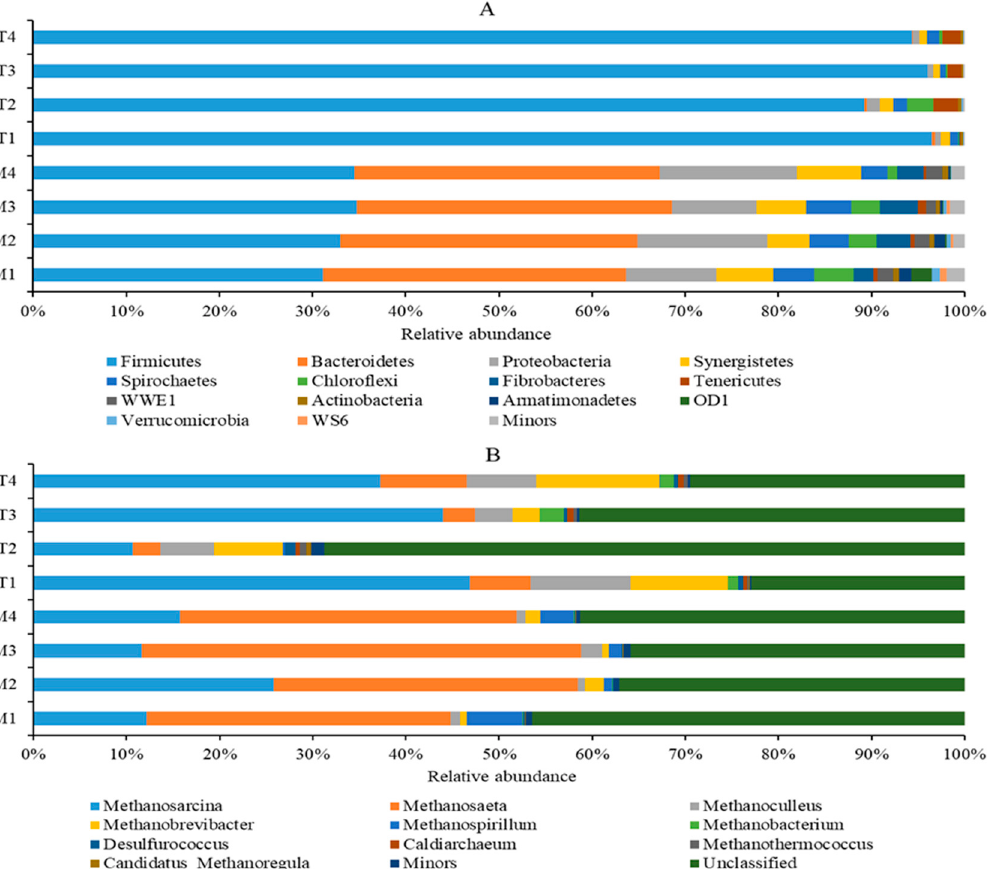
Figure 4. Microbial profiles of the bacterial genera ( A ) and the archaeal genera ( B ) (only bacterial and archaeal genera with relative abundance of ≥ 0.5% in at least one digester are presented; the rest were classified as others; all other unidentified were included in unclassified).